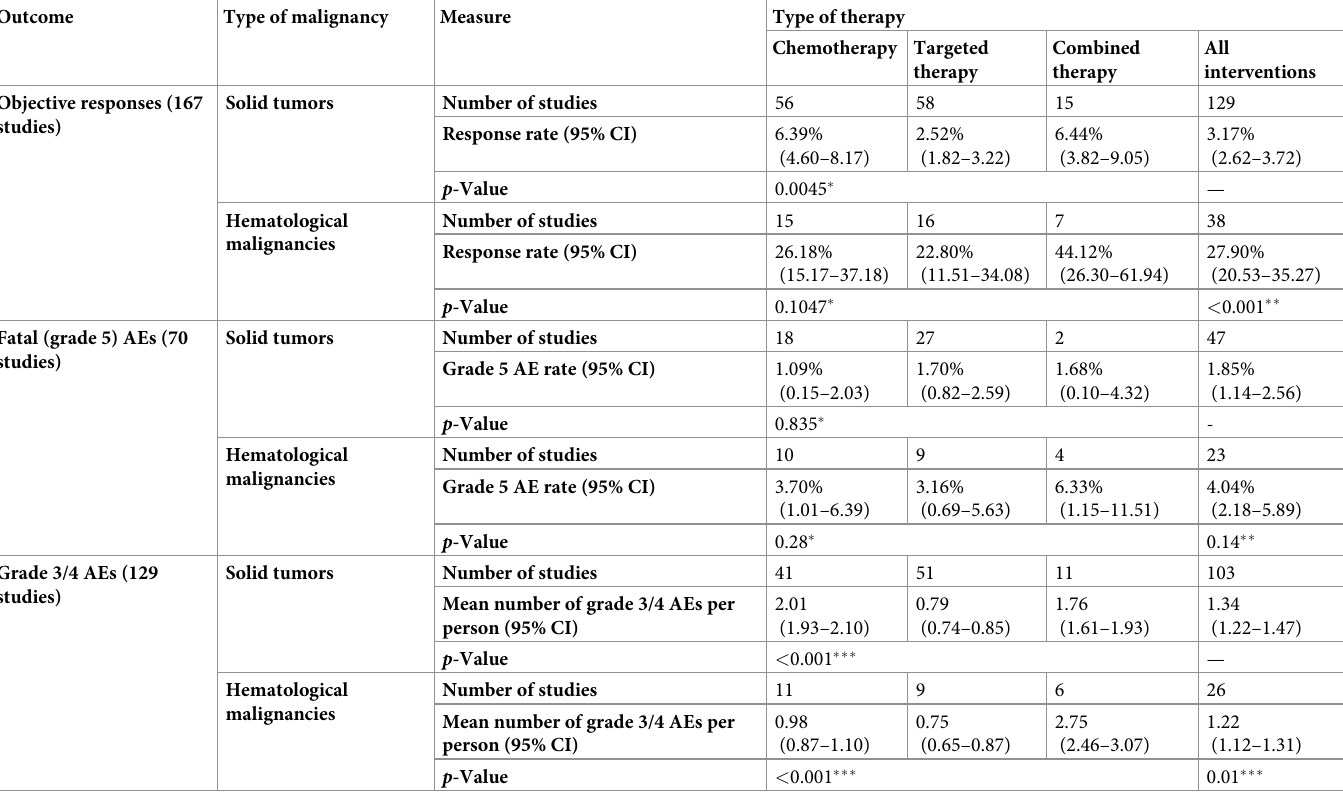
Table 3. Comparison of objective response rate and toxicity in therapy subgroups by type of